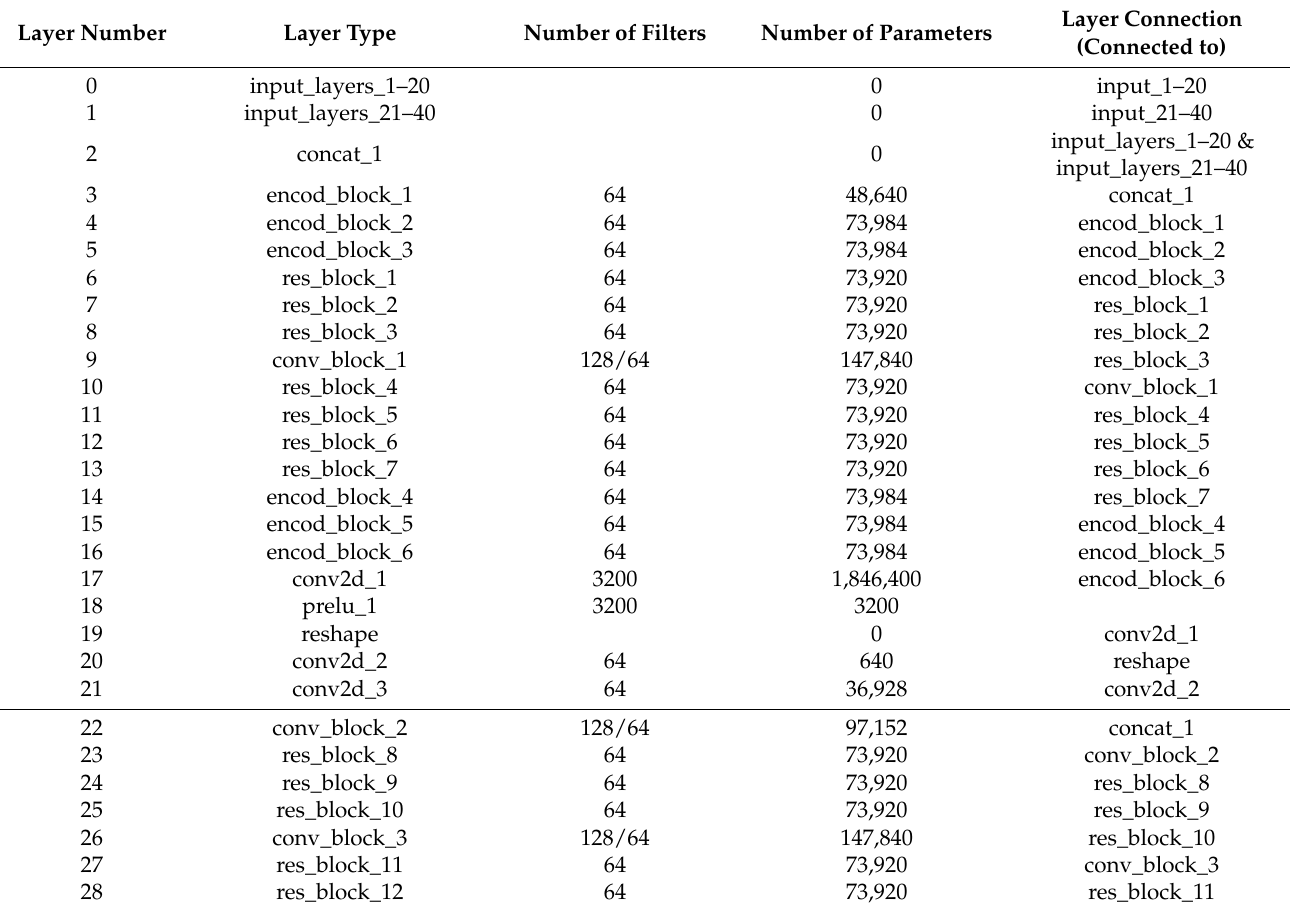
Figure 3. Example of the structure of proposed IPGAN-2. Table 3. Description of the generator of IPGAN-2.